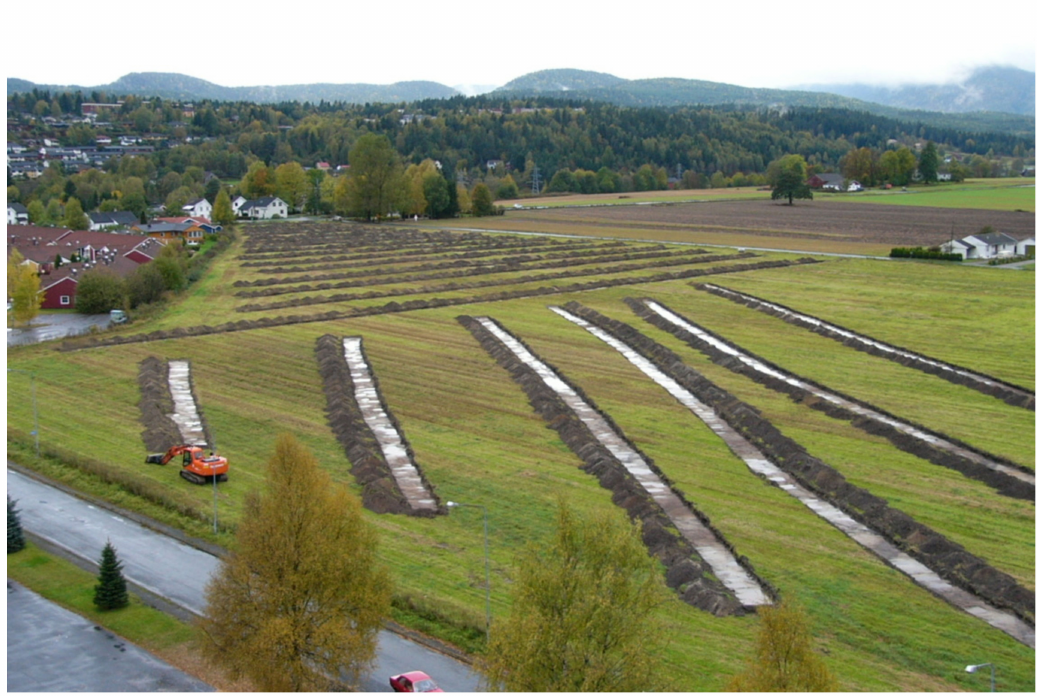
Figure 1. An example of trial trenching in arable land. Trenches 3–4 m wide have been excavated 10–15 m apart in a field. Photo by generous courtesy of Viken County